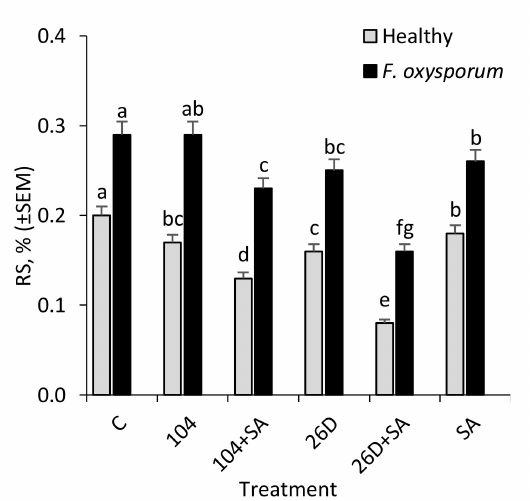
Figure 5. Changes in the contents of reducing sugars (RS) in non-infected (Healthy) and infected with the phytopathogenic fungus F. oxysporum ( F. oxysporum ) potato tubers under the influence of treatments with B. subtilis 10-4 (104), B. subtilis 10-4 + SA (104 + SA), B. subtilis 26D (26D) and B. subtilis 26D + SA (26D + SA) after six months storage. The bars are the means of three repetitions ± SEM. Di ff erent letters indicate a significant di ff erence between the means at the probability level of p <